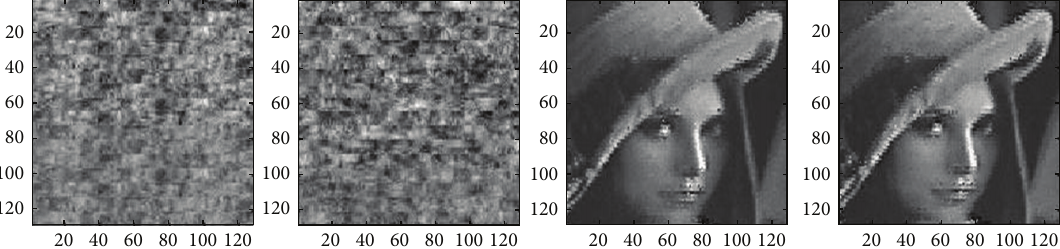
Figure 26: Selective encryption on Lena image.